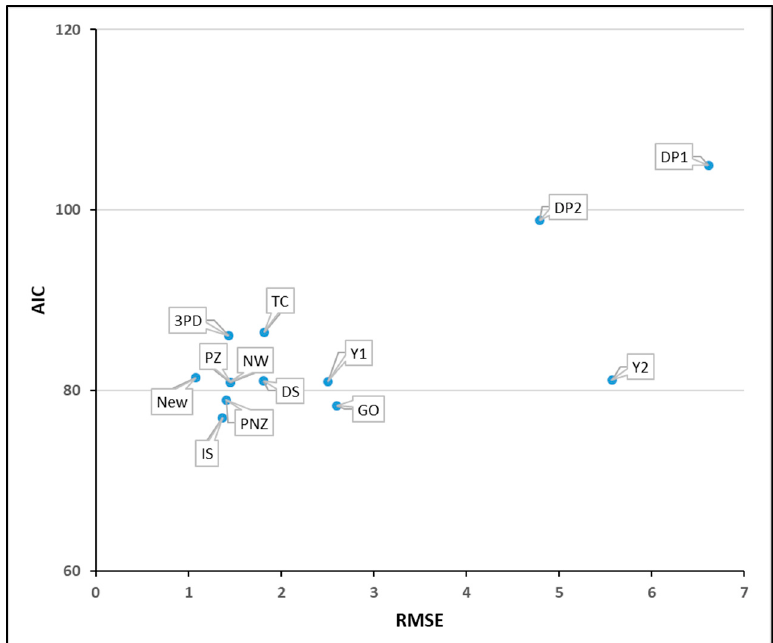
Figure 13. Comparison of RMSE and AIC for Dataset #3.